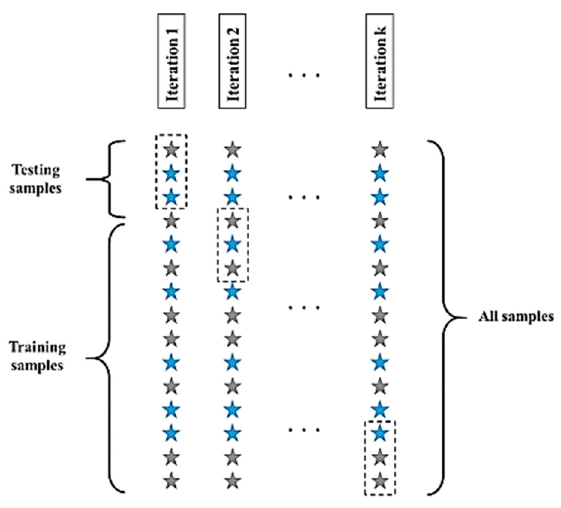
Figure 3. The k-fold cross-validation process.